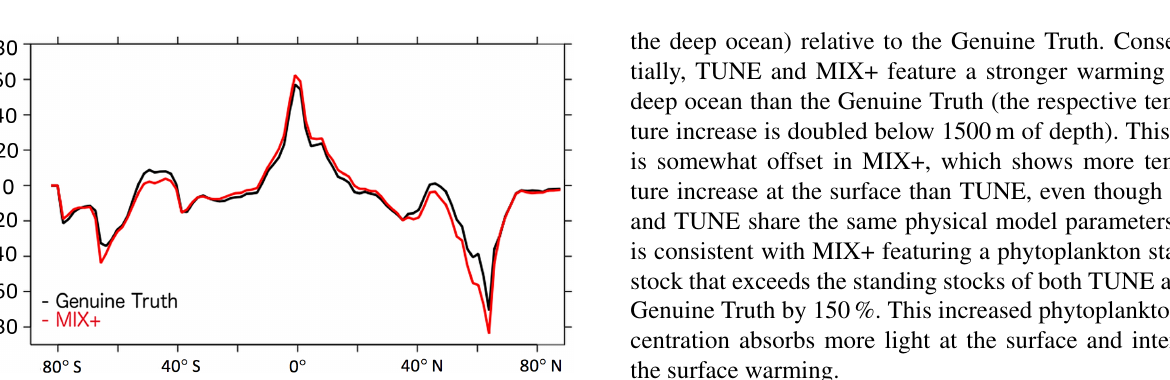
Figure 3. Simulated zonally averaged net air–sea heat fluxes in watts per square meter (Wm − 2 ) for the historical simulations (see Sect. 2.2.2). Positive numbers denote ocean warming. The black and red lines refer to results from the model configurations Genuine Truth and MIX+,